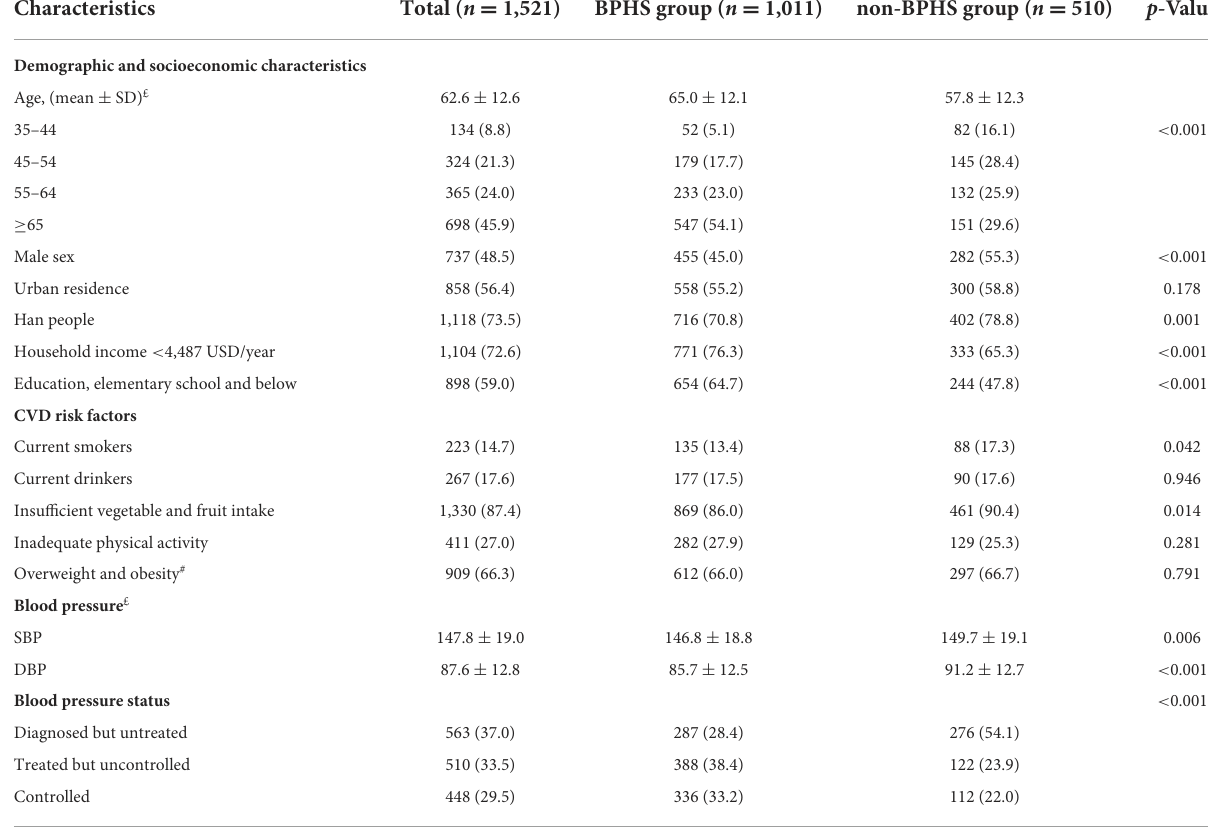
TABLE 1 Socio-demographic characteristics and distribution of CVD risk factors between the BPHS and non-BPHS groups in Yunnan, China.